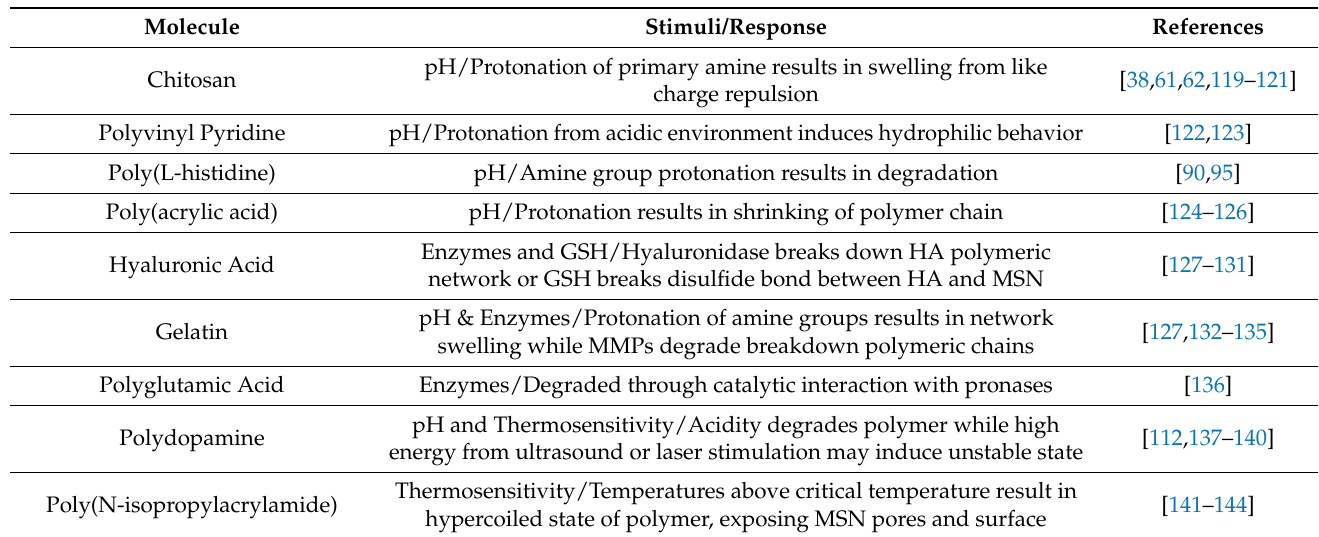
Table 1. Selection of MSN